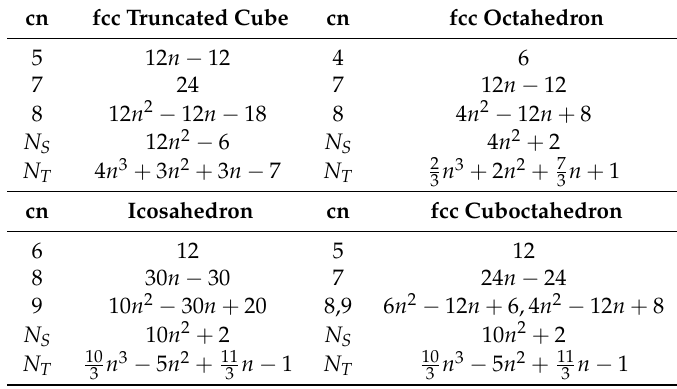
Table 1. Formulas for nanocluster shapes [11]. The variable n refers to the number of shells in the cluster, cn to standard coordination number, fcc to face centered cubic, N S the number of surface atoms, and N T the total number of atoms.